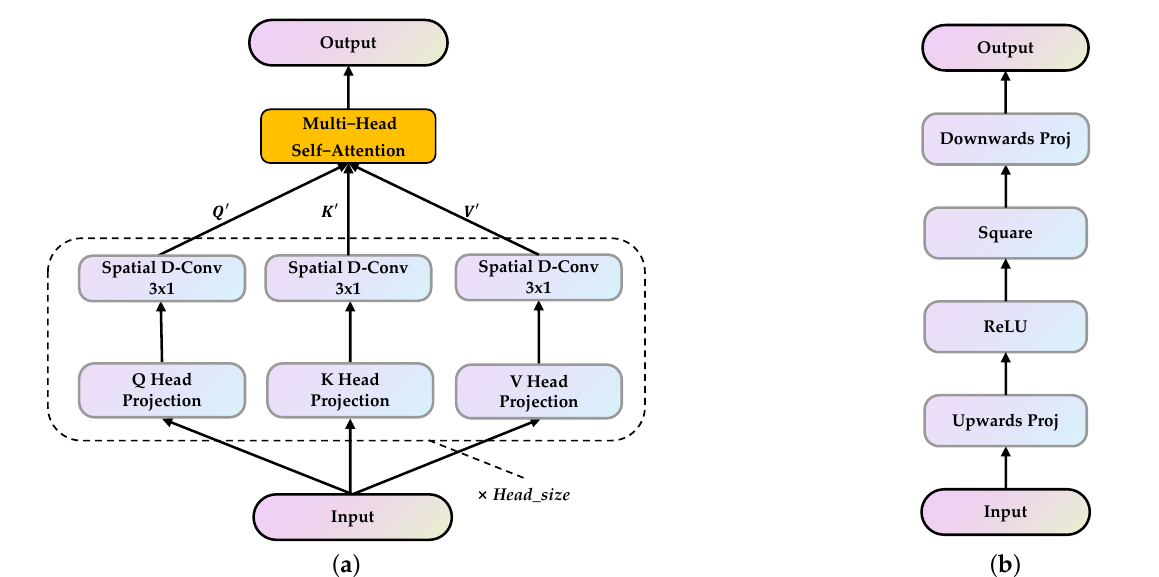
Figure 9. The structure of the Primer-EZ. ( a ) Multi-DConv-Head Attention (MDHA). ( b ) Squared ReLU.